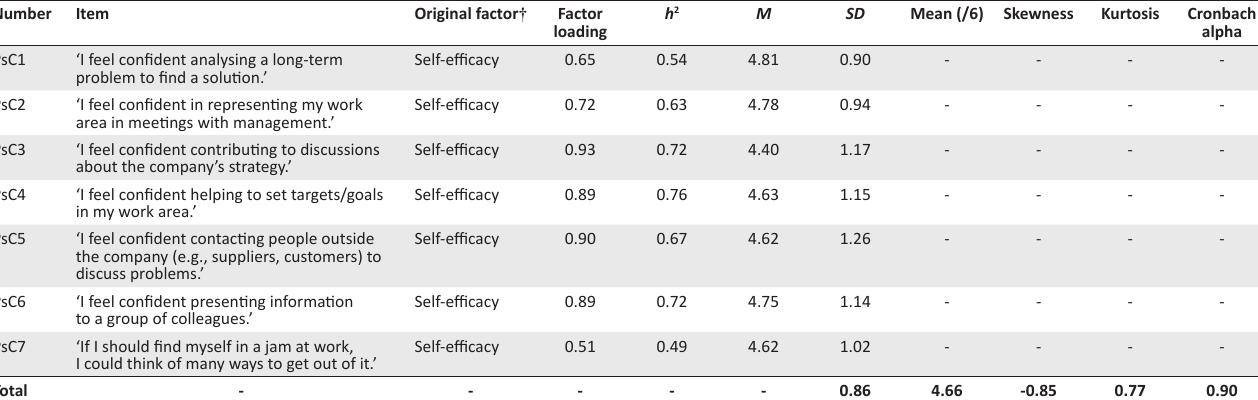
TABLE 8: Factor 1 –